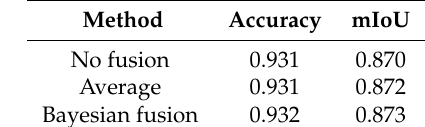
Table 7. Classification results from aggregating scores of overlapping tiles (50% overlap in this case) using different methods.